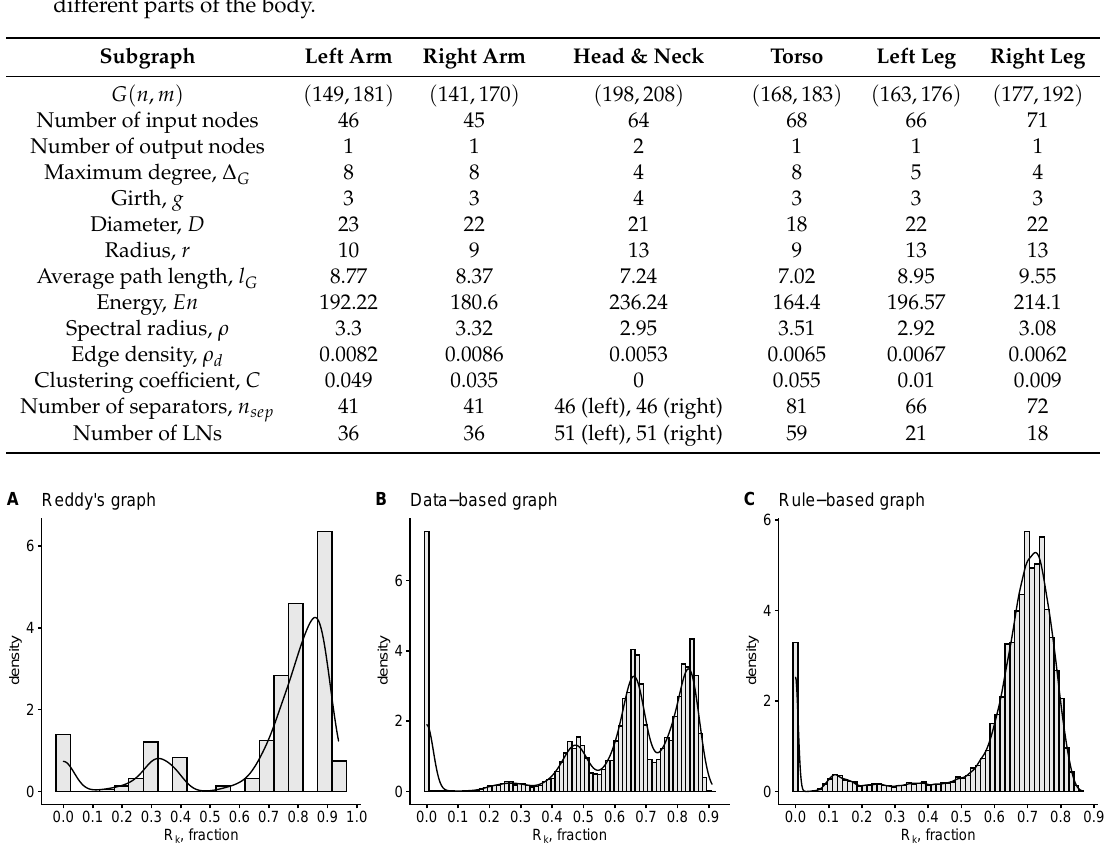
Figure 11. Histograms of the robustness of ( A ) Reddy’s graph, ( B ) anatomical data-based graph and ( C ) rule-based random graph presented in Figure